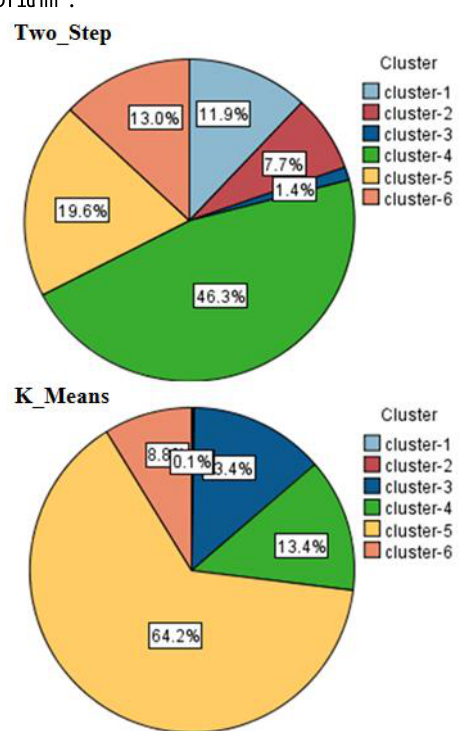
Figure 6: Two_Step and K_Means with 6 clusters.